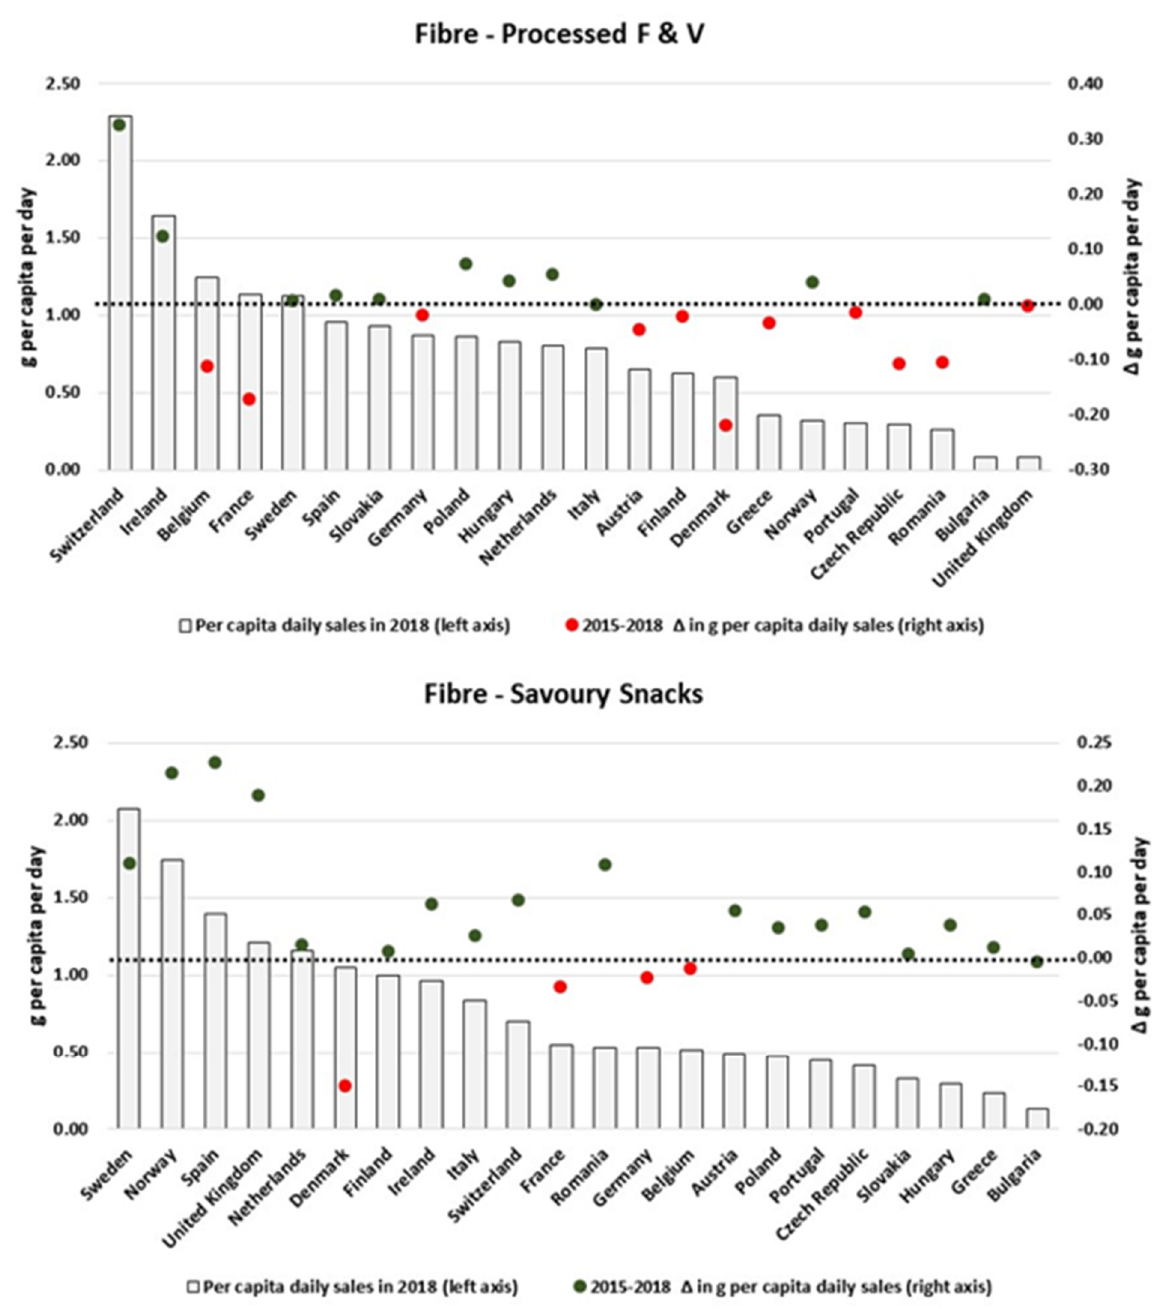
Figure 10. Estimates of fibre sold through Processed F & V and Savoury Snacks in 2018 and the respective 2015–2018 variation (in g/pc/day). Source: Elaborated by the authors based on data from Euromonitor (2020) and mid-year population estimates from the HFA-DB. Estimates were scaled by market coverage to represent 100% of the retail market. The right-hand axis represents the nutrient variation in g per capita per day (green for negative values, red for positive values), and the dotted black line indicates the variation of 0 g per capita per day as a reference.